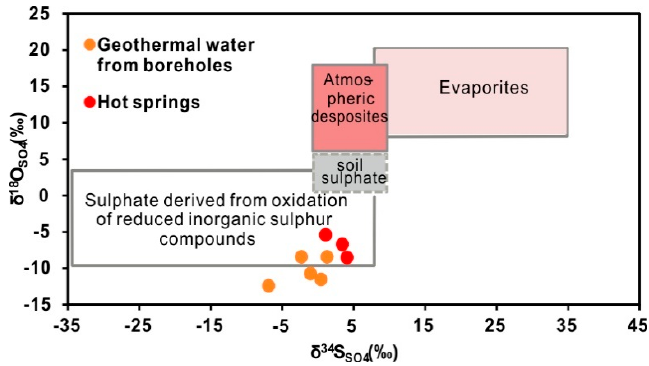
Figure 9. The plot of δ 34 S SO4 and δ 18 O SO4 for thermal waters from Ganzi. Variations in δ 34 S SO4 and δ 18 O SO4 values observed in the atmosphere, evaporites, soil sulphate and oxidized sulphur [62].